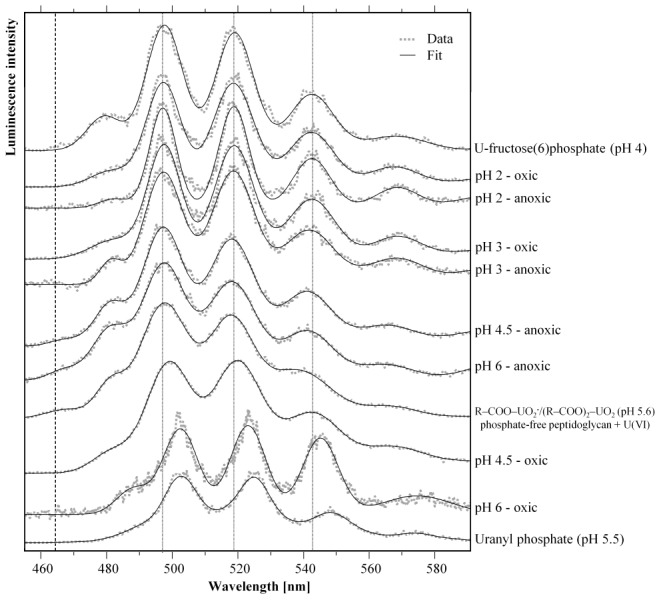
Normalized U(VI) luminescence spectra recorded from the uranium complexes formed under different pH and aeration conditions within 48 hours by the cells of Paenibacillus sp. JG-TB8.For comparison, dotted vertical lines indicate the main luminescence emission maxima recorded for the sample incubated at pH 2. The dashed vertical line marks the position of the luminescence emission peak which was assigned to uranyl carboxylate complexes.